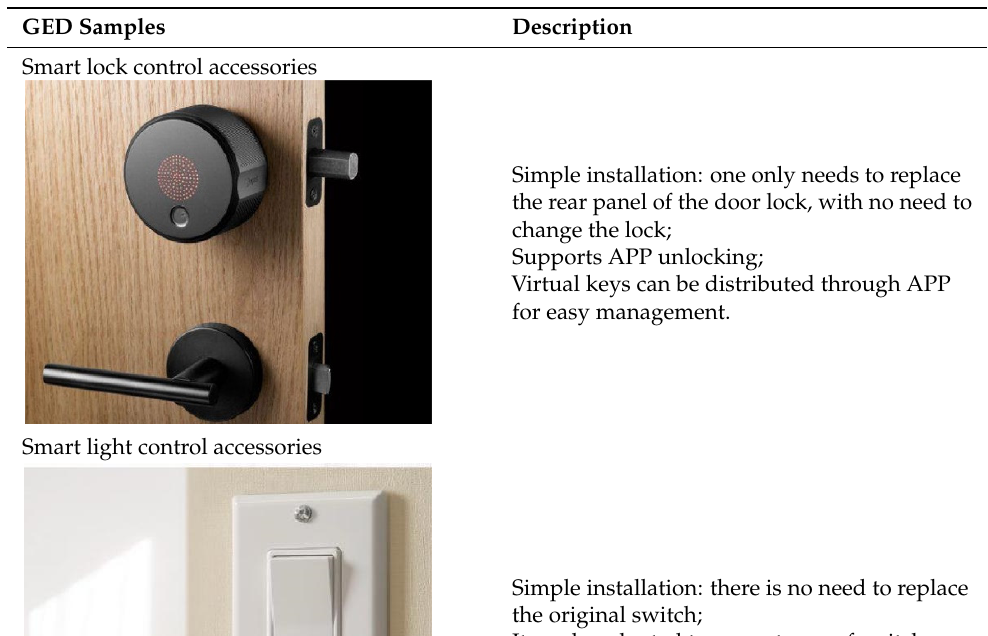
Table 1. GED representative samples.